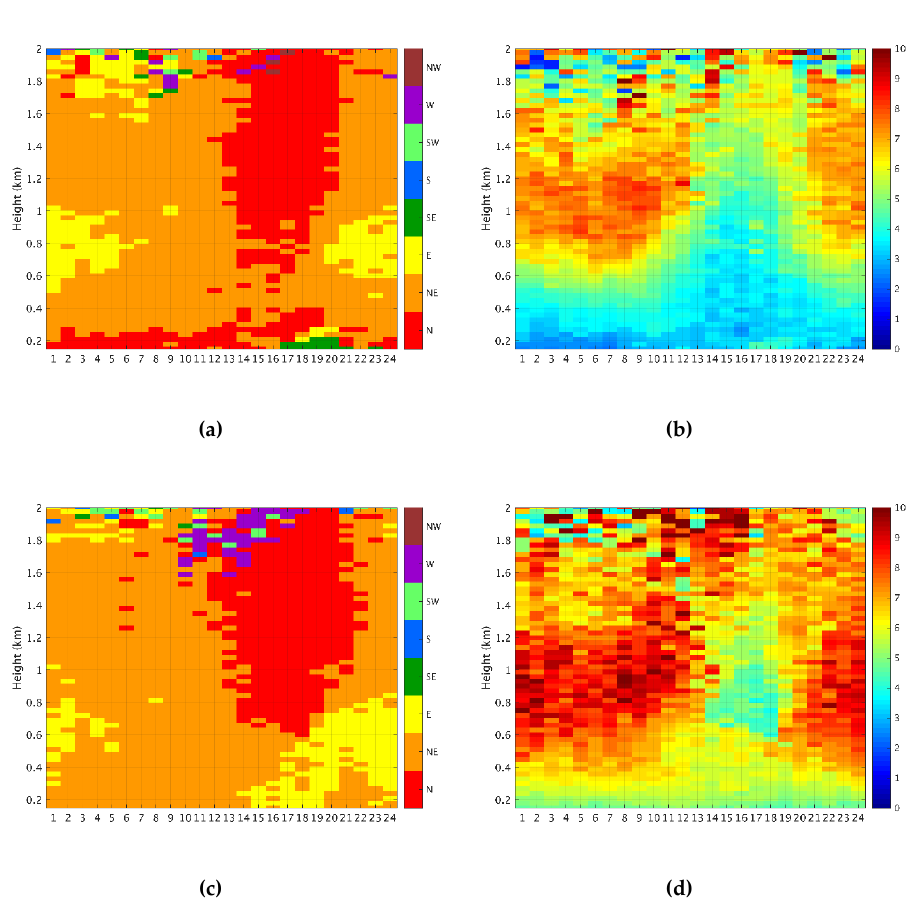
Figure 6. The diurnal vertical profiles of prevailing wind direction ( a , c ) and the mean horizontal wind speed (m / s) of the prevailing horizontal wind direction ( b , d ) at the two LiDAR stations, CUHK (upper panel) and KP (lower panel). Remote Sens. 2020 , 12 , x FOR PEER REVIEW